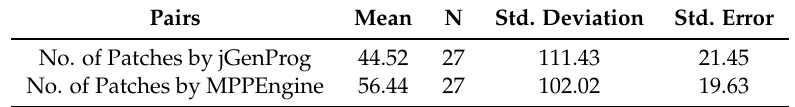
Table 4. Paired sample statistics for the number of patches generated by jGenProg and MPPEngine. Pairs Mean N Std. Deviation Std.